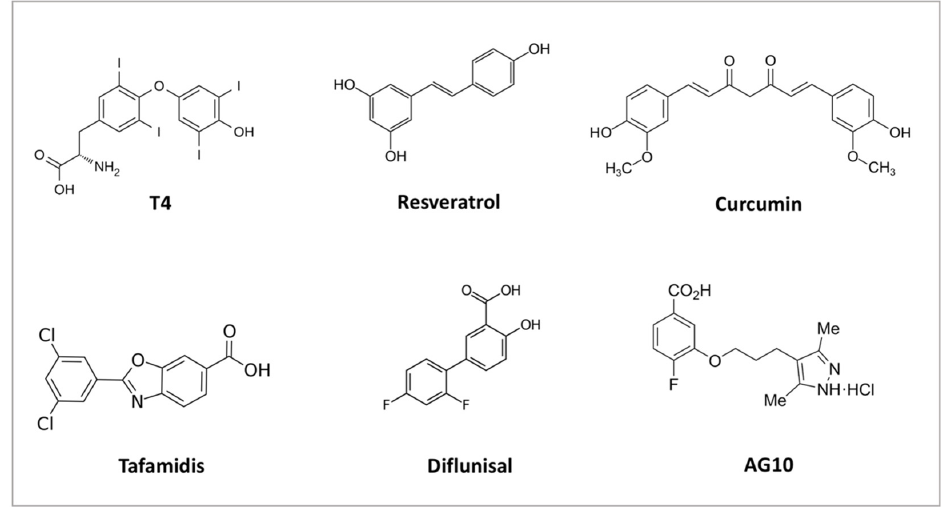
Figure 2. Chemical structure of some natural (T4, resveratrol, curcumin) and chemical ligands (tafamidis, diflunisal, AG10) able to bind and stabilise TTR tetramer. Contrary to T4, which is bound to the interior of TTR tetramers, holoRBP binds on its external surface, and each TTR tetramer has four putative binding sites for RBP, two in each dimer.